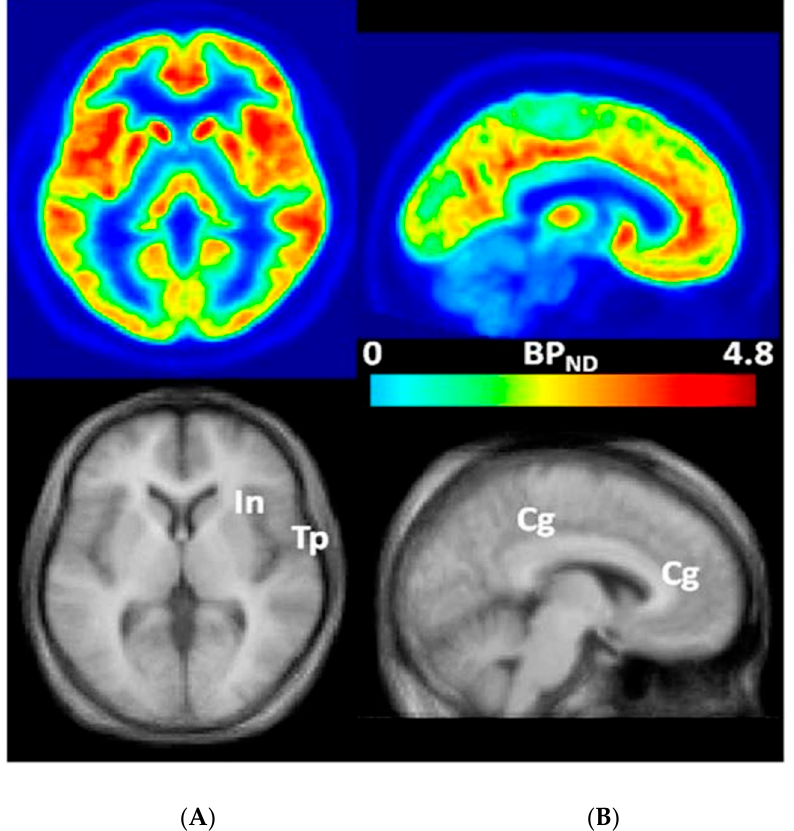
Figure 1. Transaxial ( A ) and sagittal ( B ) non-displaceable binding potential (BP ND ) [32] images of [ 18 F]FPEB ( top ) and matching magnetic resonance (MR) images ( bottom ) in statistical parametric mapping (SPM) [33] standard space. Regions with high BP ND values, namely insular (In), temporal (Tp), and cingulate (Cg) cortices, are indicated on co-registered MR images [30]. This research was